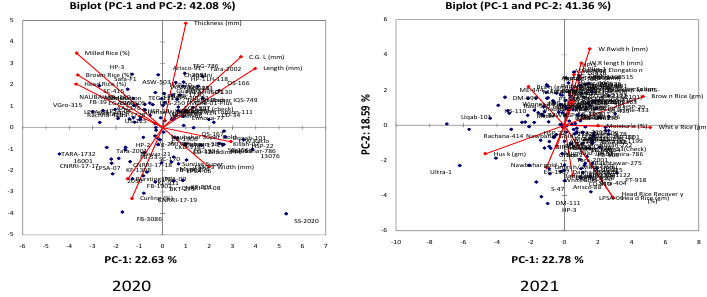
Figure 5. Biplot PCA analysis of various hybrid rice varieties and their traits association with principal component numbers under adaptability trials